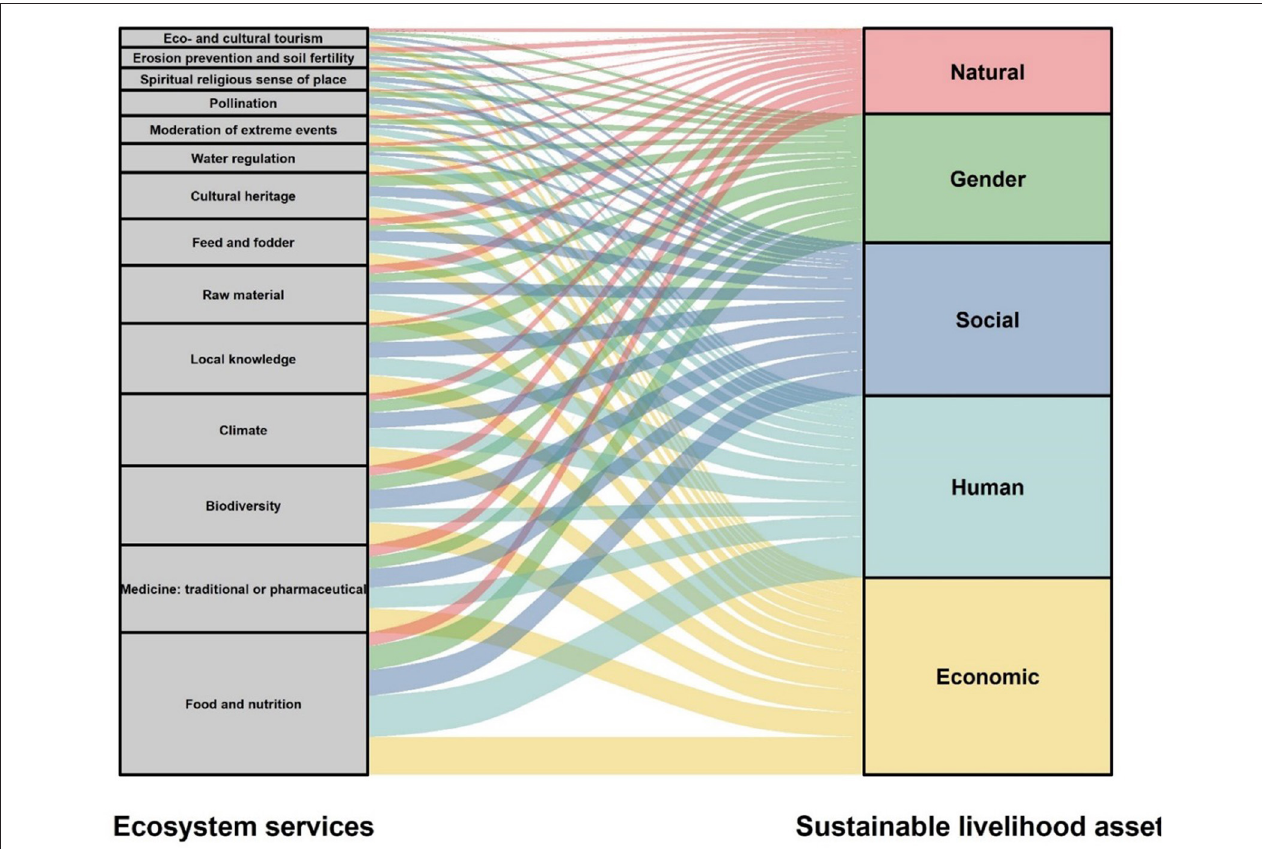
FIGURE 2 | Potential contribution of ecosystem services (The Economics of Ecosystems Biodiversity, 2008) provided by NUS to the provision of sustainable livelihood assets for marginalized groups, based on literature. The height of a block is proportional to the number of ecosystem services included in the cluster, and the width of a stream field is proportional to the number of ecosystem services included in both clusters connected by the stream.